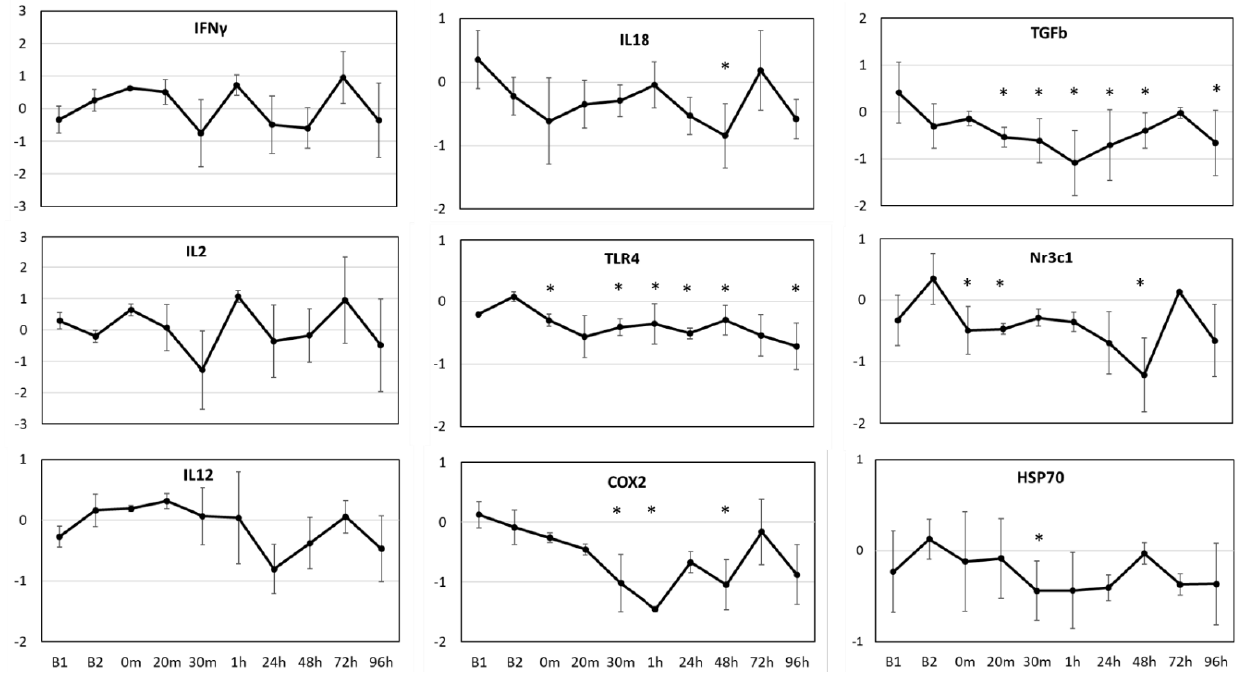
Figure 3. Average relative gene expression changes (Log2 fold-change, y-axis) across the time points (x-axis) for the study in relation to the average baseline values (y = 0) for three aquarium whales. B1 indicates the average value for the baseline samples taken 7 days prior, and B2 indicates the average value for the baseline samples taken 1 day prior to OWE event. Samples taken during the OWE are in minutes: 0 m, 20 m, 30 m; and post-OWE are in hours: 1 h, 24 h, 48 h, 72 h, 96 h. Error bars represent the standard error of means. Statistically significant differences from the average baseline values are indicated with asterisks (Posthoc pairwise test with Sidak correction * p < 0.05).